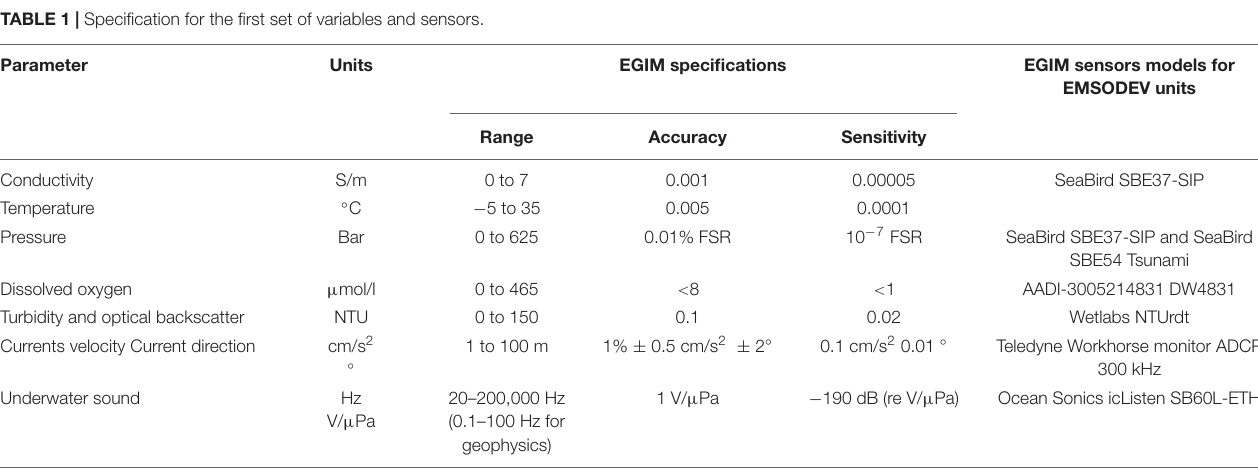
FIGURE 2 | (A) The EGIM assembled and ready for deployment (B) view of the sensors and components and (C) sensors diagram with communication services. TABLE 1 | Specification for the first set of variables and